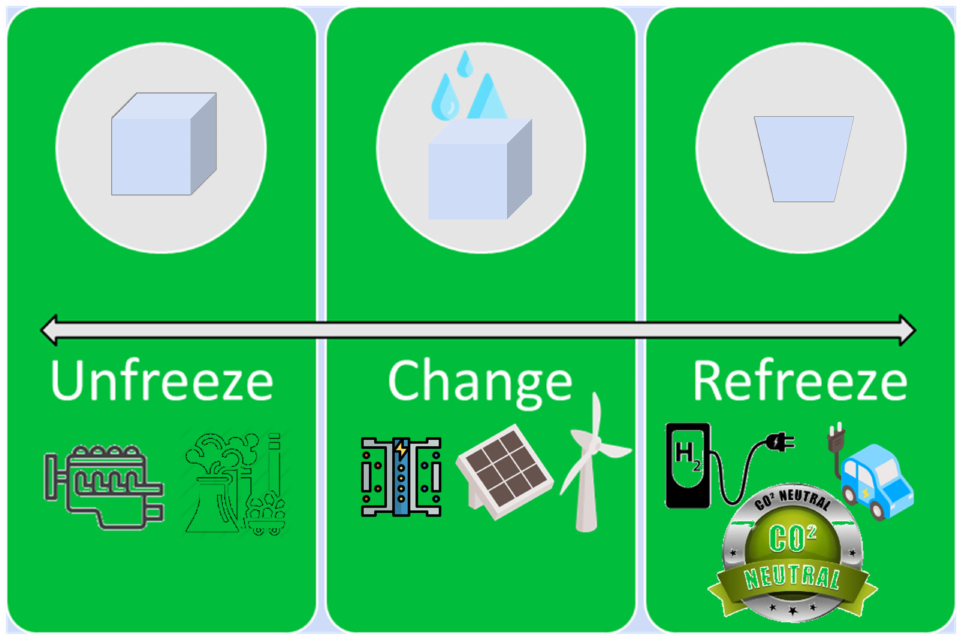
Figure 3. Demonstration of a three-step change management approach towards the use of new energy vehicles and a CO 2 neutral climate analogue to Lewin